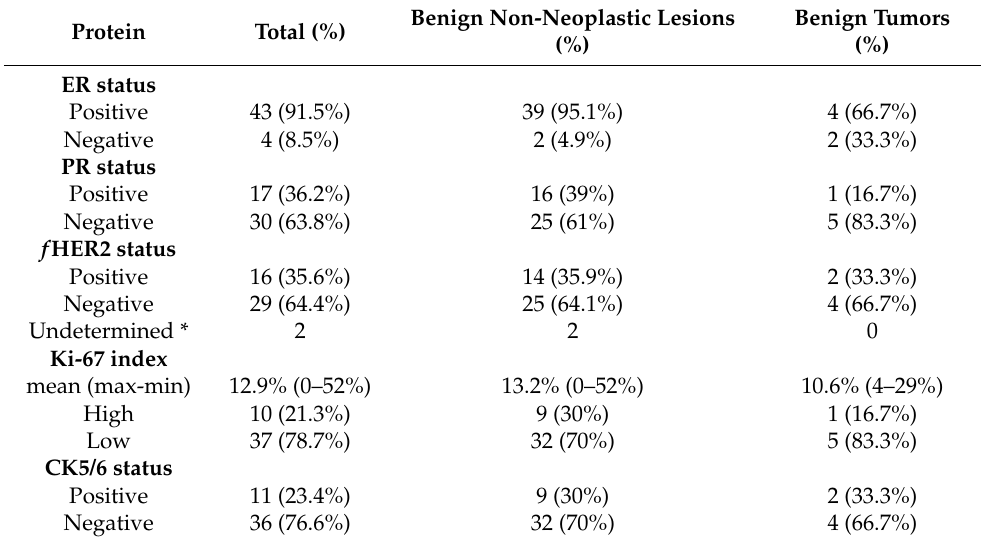
Table 5. Immunohistochemical results for ER, PR, HER2, Ki-67 and CK5/6